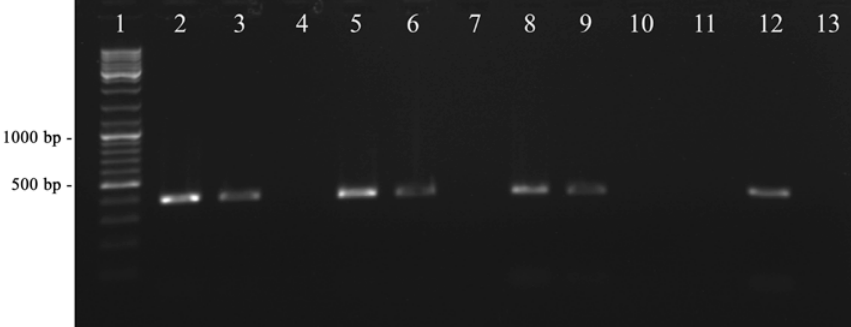
Figure 2 . Gel electrophoresis of Phytophthora pistaciae i solates detected by nested-PCR with ITS-SF1 and ITS-SR1 primers